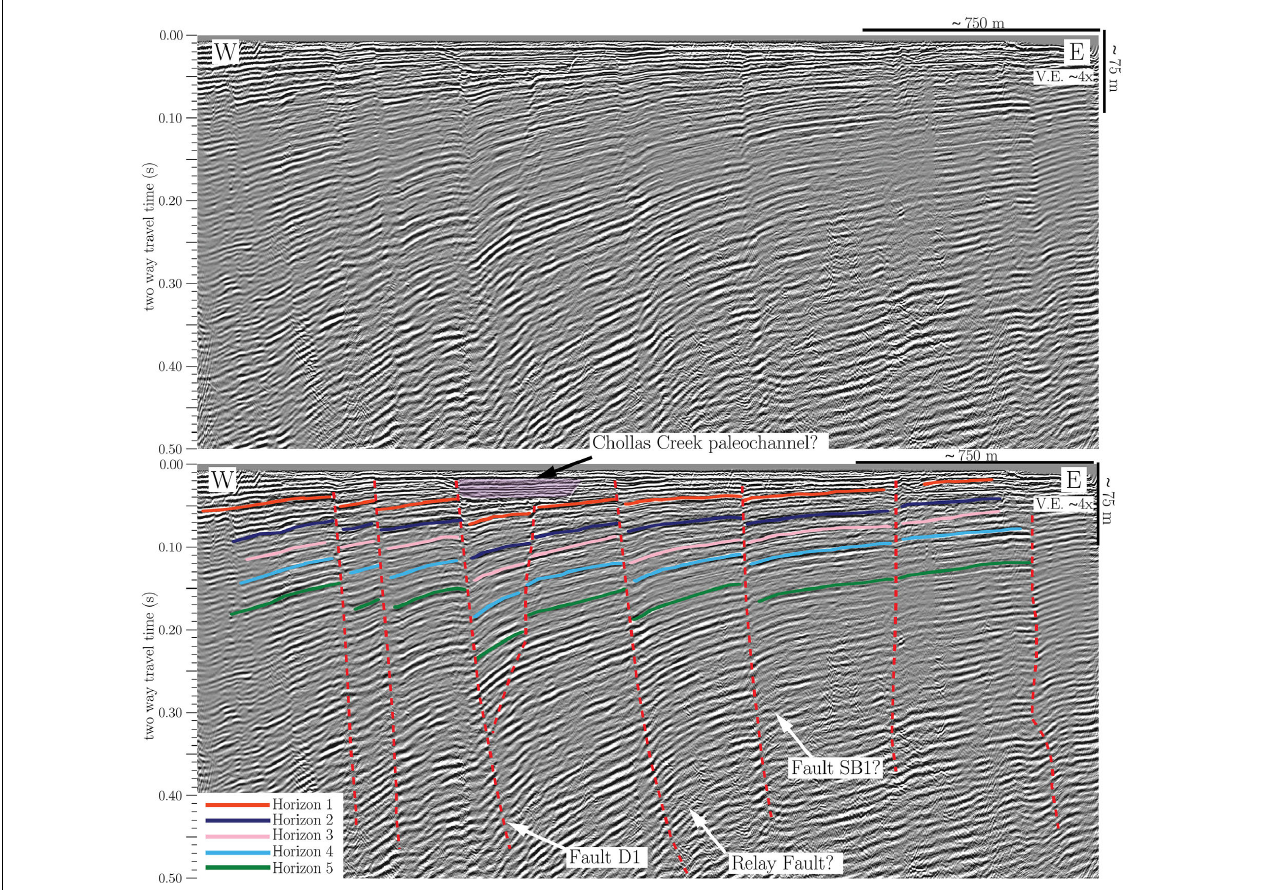
FIGURE 4 | MCS profile T196-088 showing distributed faulting associated with Fault D1, and potential relay fault structure between Faults D1 and SB1. Location shown in Figure 2